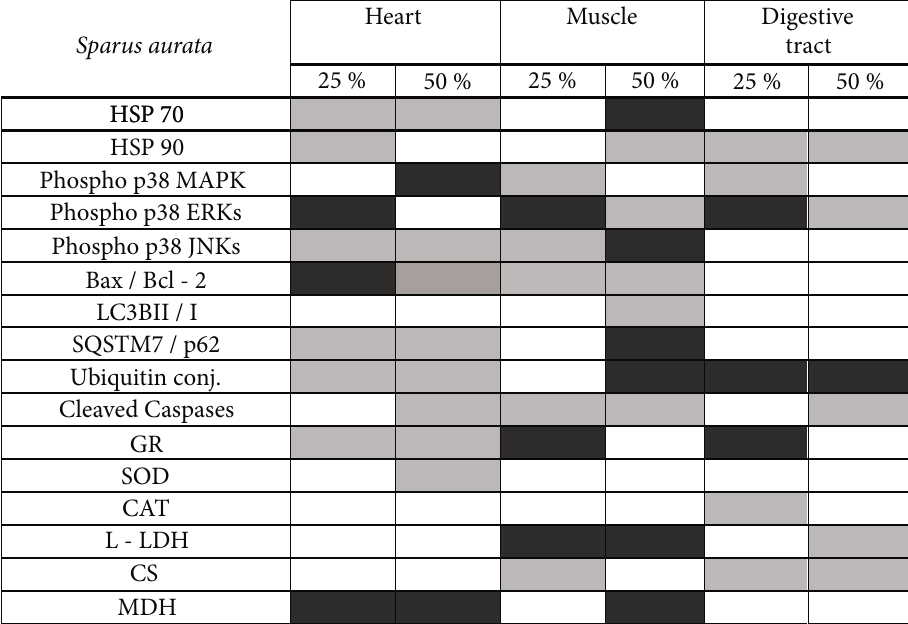
Figure 9: E ff ect of partial substitution (25 and 50%) of fi sh meal with insect meal (IM) on the four examined tissues (heart, liver, muscle, and digestive tract) of the gilthead sea bream ( Sparus aurata ). Dark grey indicates increase, light grey indicates decrease and white indicates no change compared to the fi sh meal – control (0% substitution).